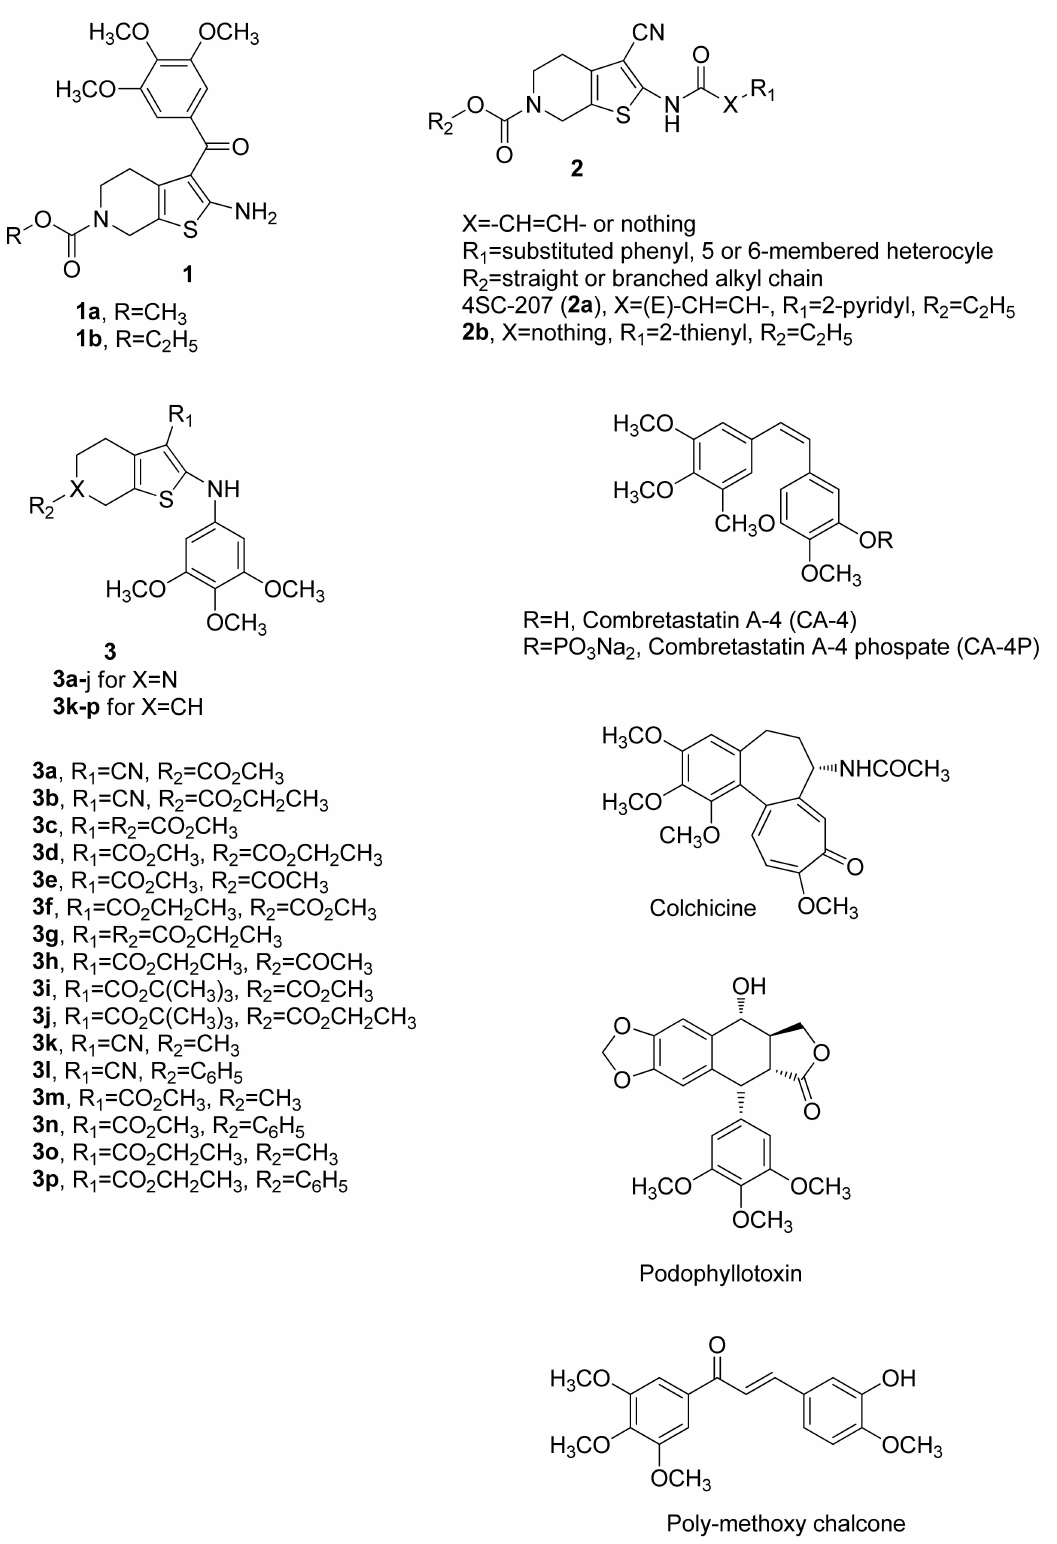
Figure1. Structuresoftetrahydrothieno[2,3- c ]pyridines 1 – 3 . Compoundswitha3,4,5-trimethoxyphenyl moiety, such as colchicine, CA-4, podophyllotoxin, and